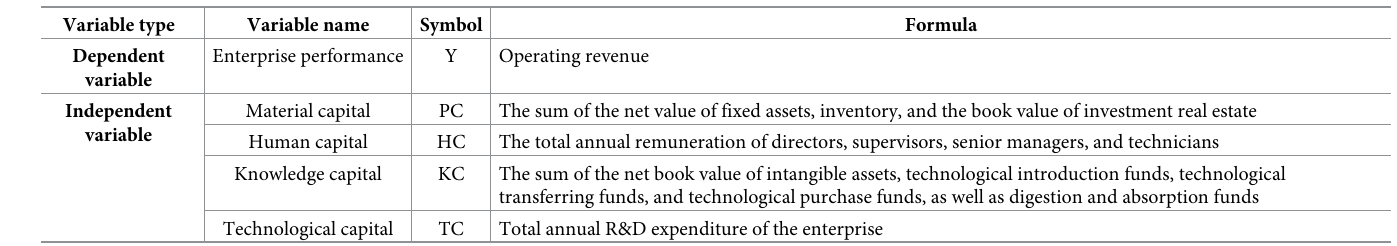
Table 1. Definition and formula of variables (unit: